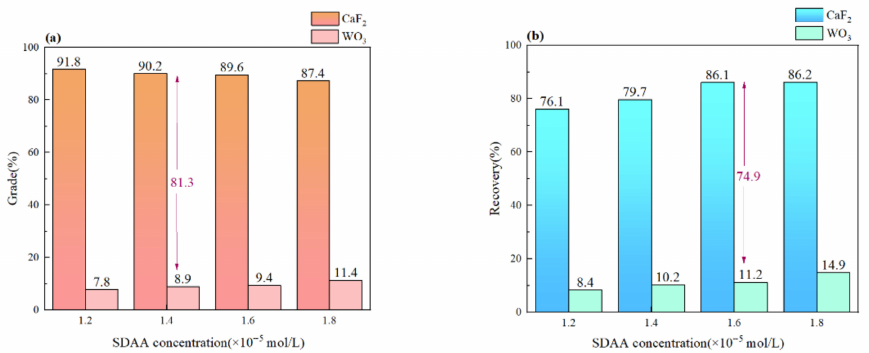
Figure 4. ( a ) Grade of CaF 2 and WO 3 in fluorite concentrate as a function of SDAA concentration at pH 7.0 in binary mixed mineral tests and ( b ) recovery of CaF 2 and WO 3 in fluorite concentrate as a function of SDAA concentration at pH 7.0 in binary mixed mineral tests.